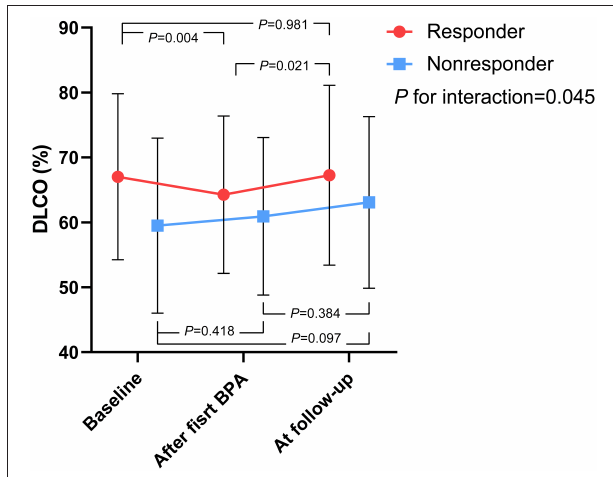
FIGURE 2 | The time course of DLCO values during the BPA procedure, stratified by BPA responders and nonresponders. P for interaction represents the interaction between the outcome of BPA and time course as within-subjects effects. BPA, balloon pulmonary angioplasty; DLCO, diffusing capacity for carbon monoxide.